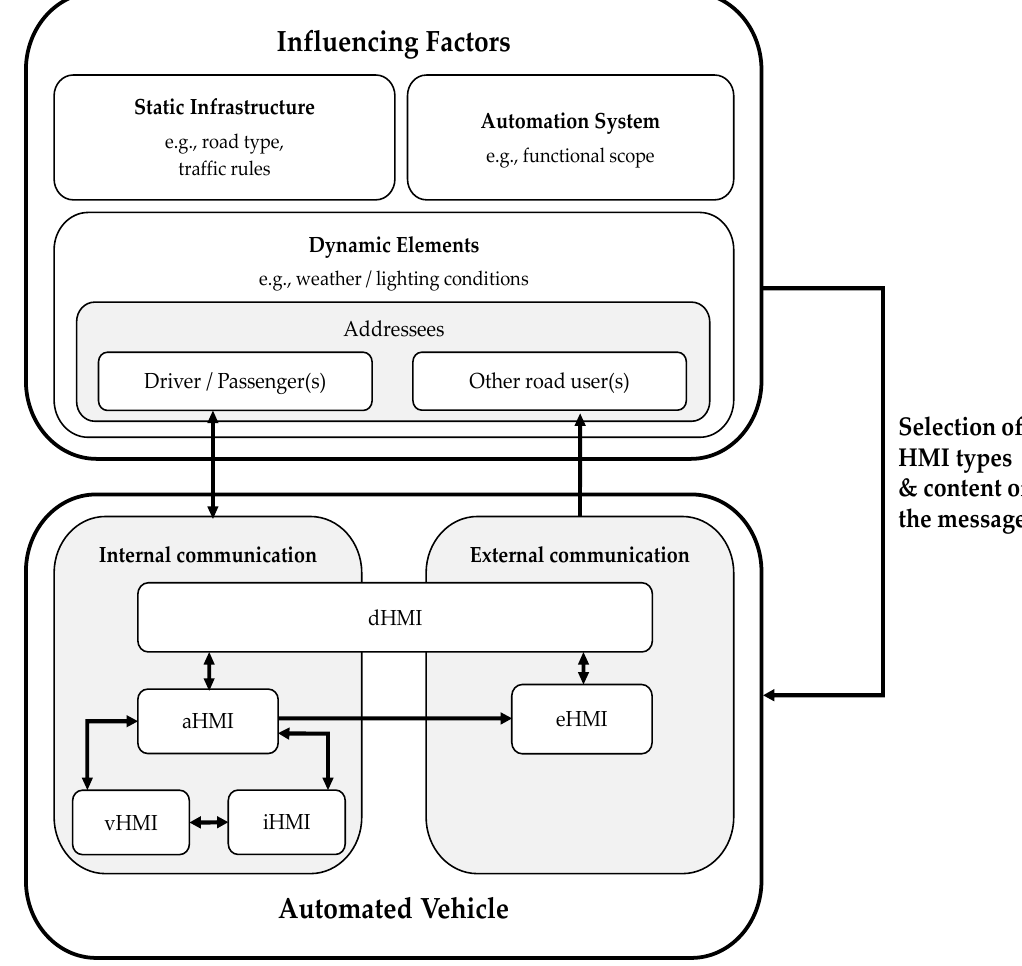
Figure 1. The HMI framework including the factors influencing the HMI characteristics and selection on the upper part, and the different HMI types dynamic HMI (dHMI), vehicle HMI (vHMI), infotainment HMI (iHMI), automation HMI (aHMI), and external HMI (eHMI) on the lower part.